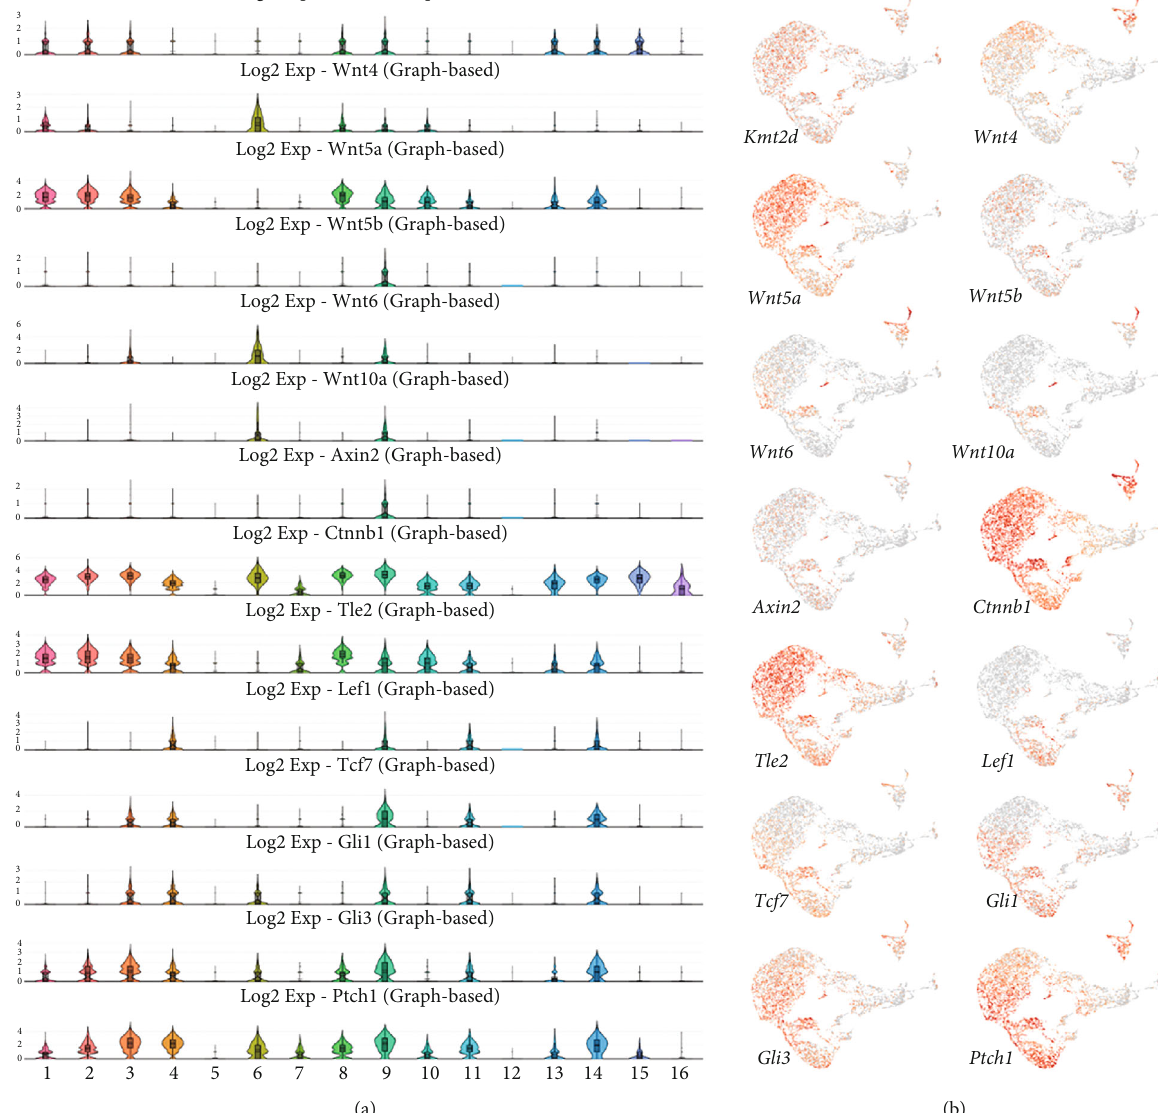
Figure 3: Expression of genes encoding downstream targets of KMT2D and KDM6A. (a) Violin plots of genes encoding Wnt5a , Ctnnb1 , Tle 2, Gli3 , and Ptch1 . (b) UMAP visualization of genes encoding components of the WNT and SHH signaling